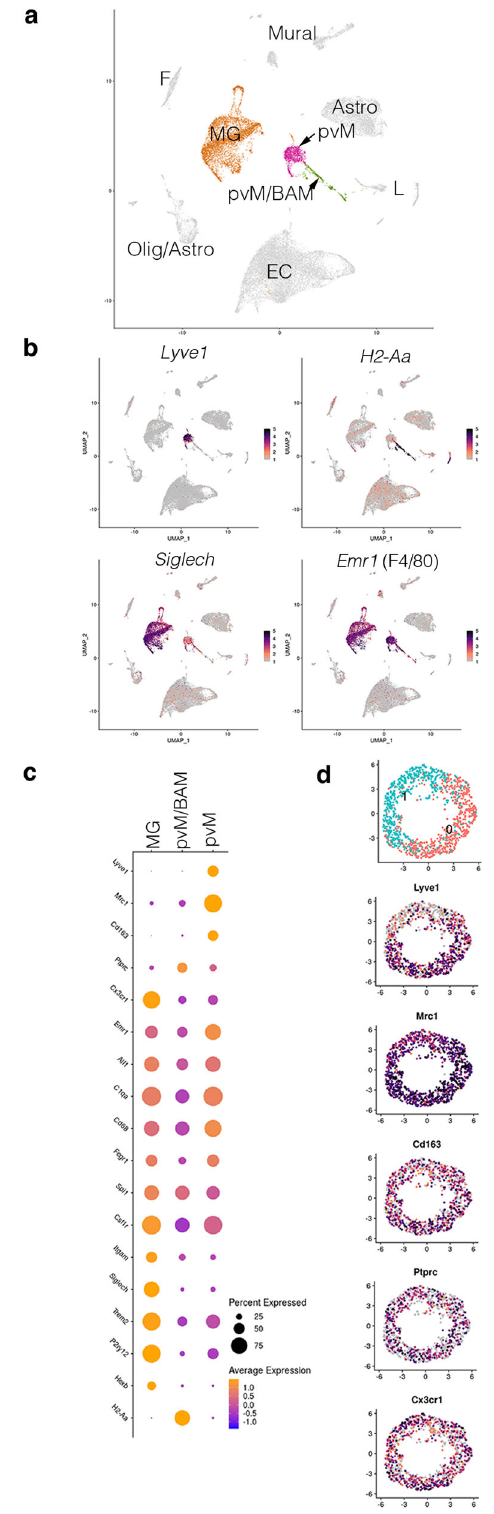
Fig. 4 | Transcriptional pro fi ling of the pvM subsets. Replicates of mouse brain cortex, excluding neurons and meninges. Shown is the integrated dataset of sam- plesat10days( n =3,12,843cells),adult(7 – 11weeks, n =2,7817cells),andaged(1.5 years, n =3, 10,448 cells). Cluster analysis on integrated data ( a ) focused on the pvM, the pvM/BAM and the microglia clusters. b The pvM cluster was indicated as the sole cluster with Lyve1 expression, but H2-Aa (encoding one of the MHC-II genes) negative. This population was segregated completely from the Siglech expressionmicroglia,whichwasalso Lyve1 – . Emr1 (encodingF4/80)isexpressedin all 3 clusters. c Dot-plot of the genes associated with macrophage or microglial identity,showingthatpvMsistheonlyclusterwhichisexpressing Lyve1 .pvM/BAM ischaracterizedby H2-Aa expression,butlacking Lyve1 .Themicrogliapopulationin cluster 3 was identi fi ed by lack of Lyve1 , CD163 , H2-Aa , and low Mrc1 (encoding CD206) or Ptprc (encoding CD45) expression. EC endothelial cell, MG microglia, pvM perivascular macrophage, BAM border-associated macrophage, L Lympho- cytes, F fi broblast, Astro astrocyte, Olig Oligodendrocyte, Mural Mural cells. d Cell from the cluster with the highest Lyve1 expression, the pvM, were isolated to analyzeapossiblesegregationin Cx3cr1 + and Cx3cr1 – expressionpopulation within this population. Even though we observed 2 subclusters, also based on Lyve1 expression, there was no segregation based on Cx3cr1 or Ptprc